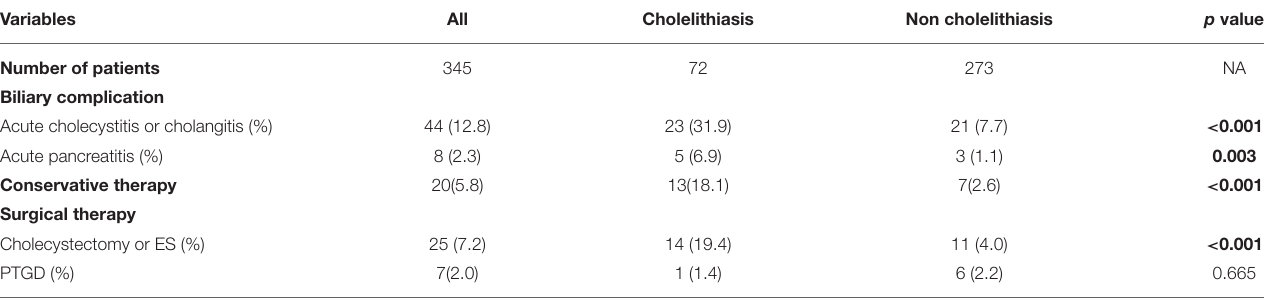
TABLE 5 | The complication in adult patients with SBS with and without cholelithiasis. Variables All Cholelithiasis Non cholelithiasis Number of